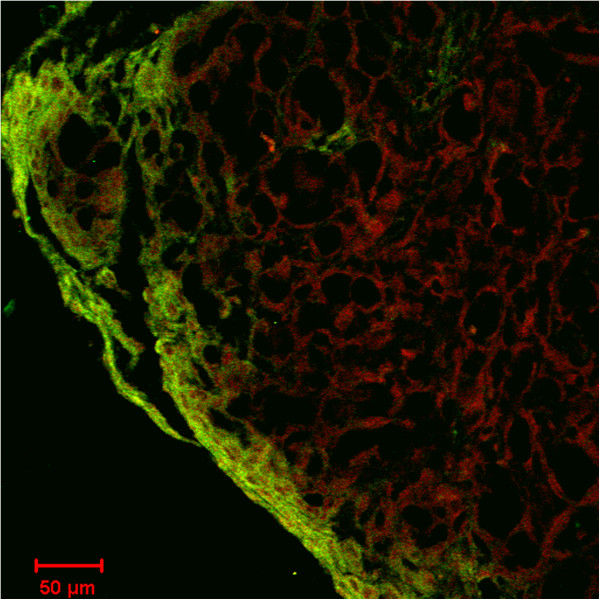
Observation of ovary 3 months after inoculated OVCAR3 cells in group B under × 200 confocal laser scanning microscope. Green light labels: ovary tissue of mouse. Red light labels: OVCAR3 transplanted tumor of human epithelial ovarian cancer.